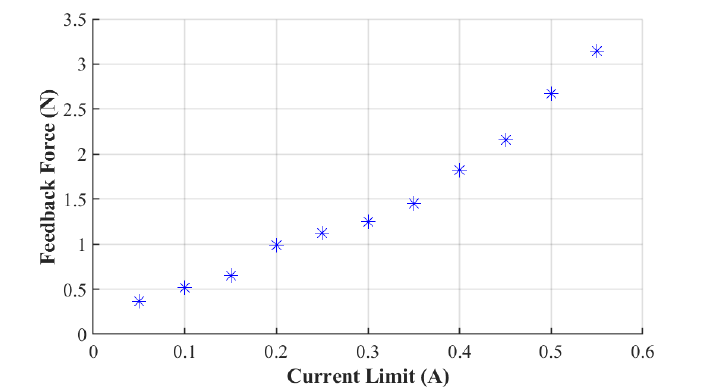
Figure 12. Resulting feedback force versus current limit. Each “*” represents one data point obtained from the test shown in Figure 11.